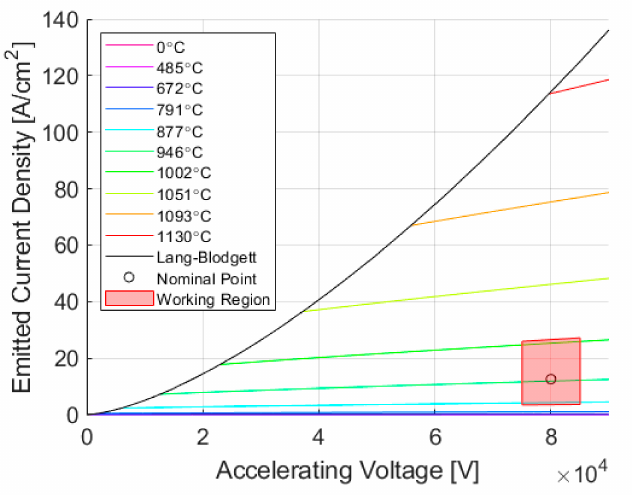
Figure 4. Graphical representation of the operational regimes of the